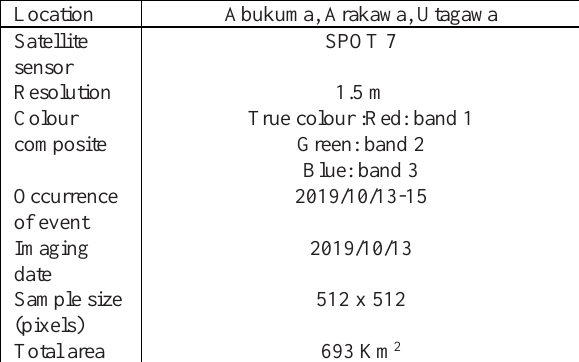
Table 3. Test data sets used in the study